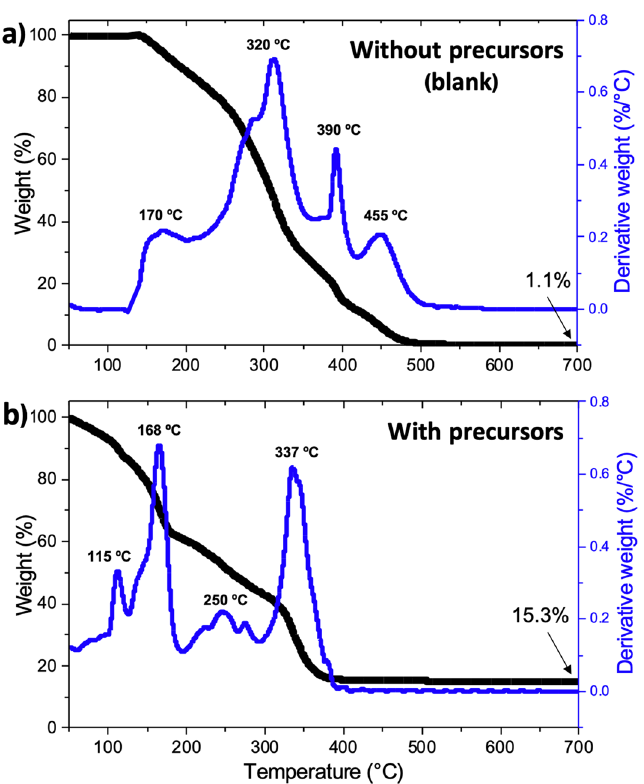
Figure 2. TG and DTG curves of UV-polymerized pieces from ( a ) blank resin without precursors, and ( b ) blank resin containing NMC precursors. The peak temperatures are only indicated for the major